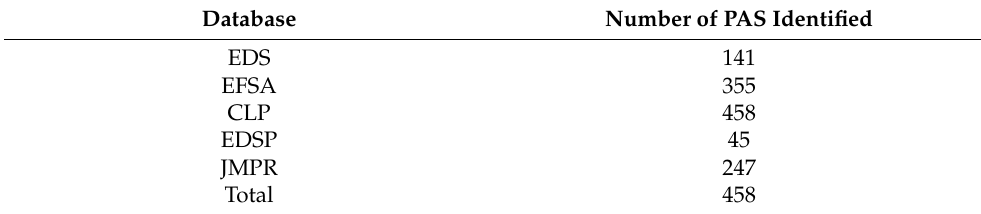
Table 2. Number of phytopharmaceutical active substances (PAS) identified by database.